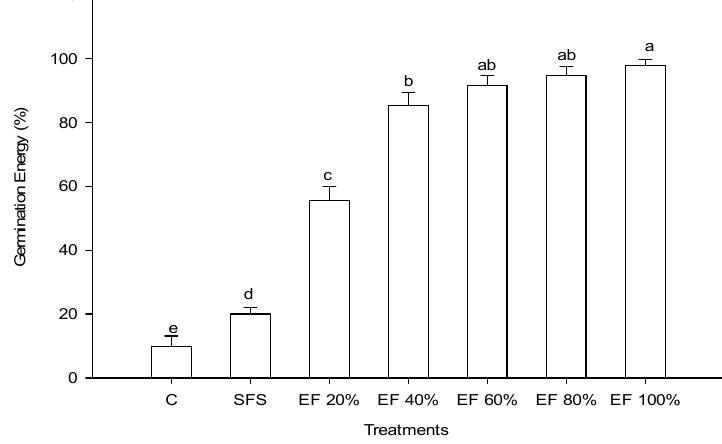
Figure 9. Effect of LSEs on germination energy of cherry tomato seeds.